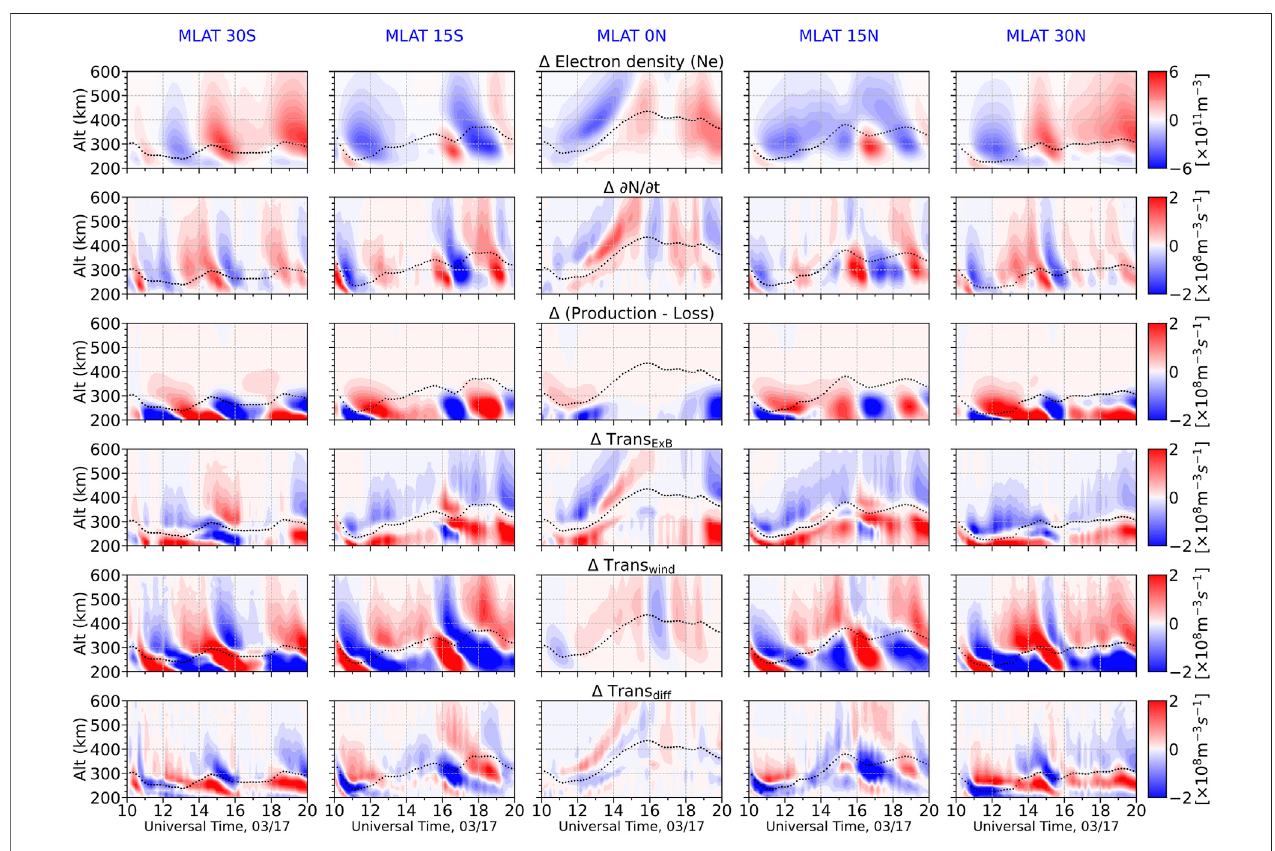
FIGURE 7 | The storm-quiet differences of the electron density (top panel) and terms in Eq. 2 (second to last panels) at fi ve locations at 70 ° W. For each plot, the parameter is shown as a function of universal time and altitude and the dotted line denotes the HmF2 on 03/17.